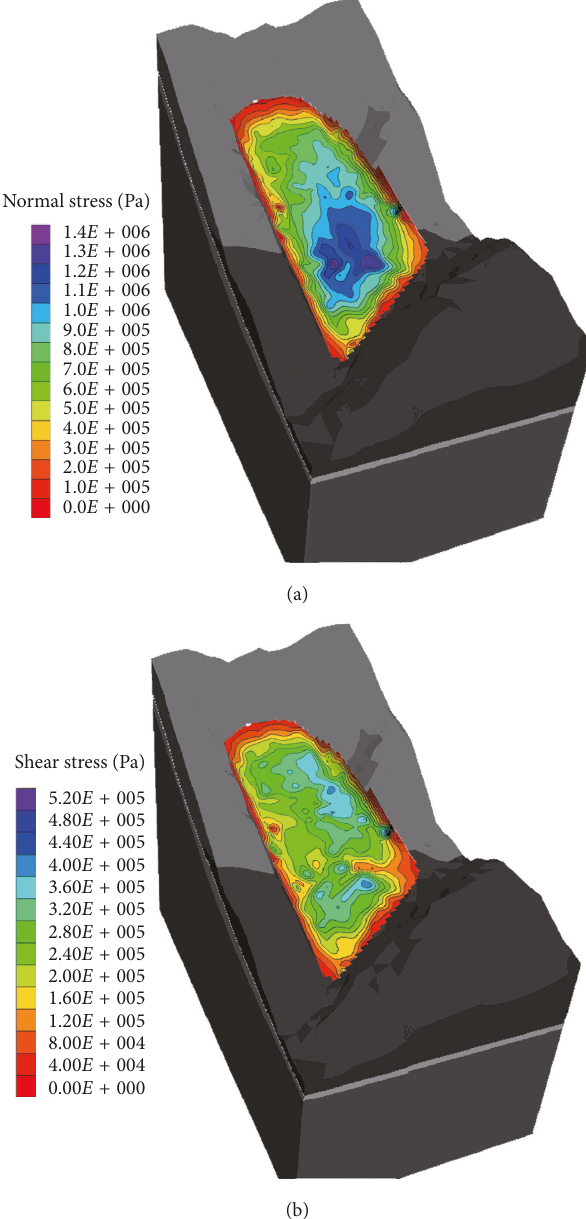
Figure 9: Distribution of normal stress (a) and shear stress (b) after